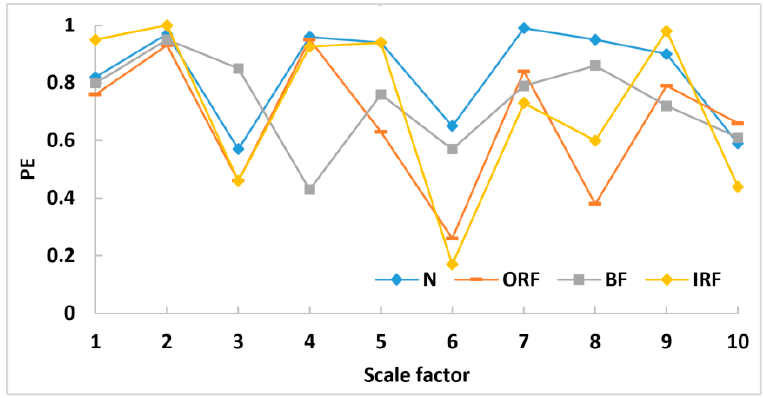
Figure 13. MPE of IMF3 for four health conditions.